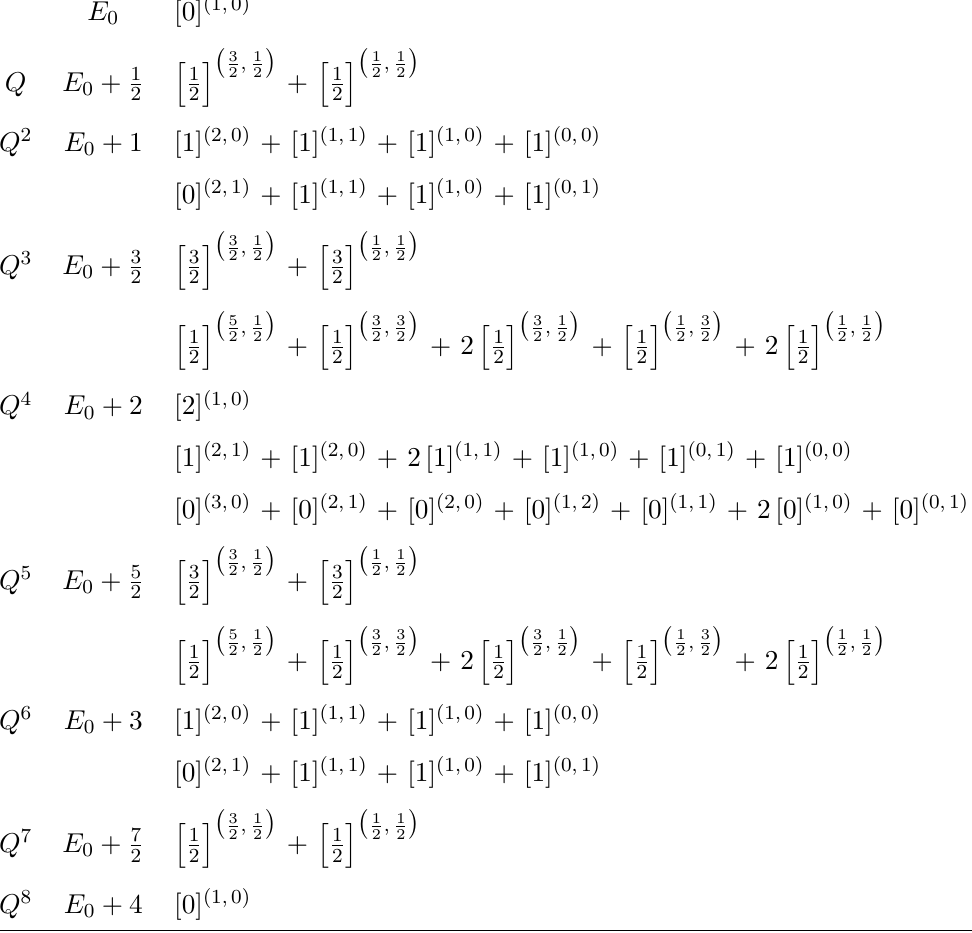
Table 6 . States in the long graviton supermultiplet LGRAV 4 [ E 0 , 1 , 0]